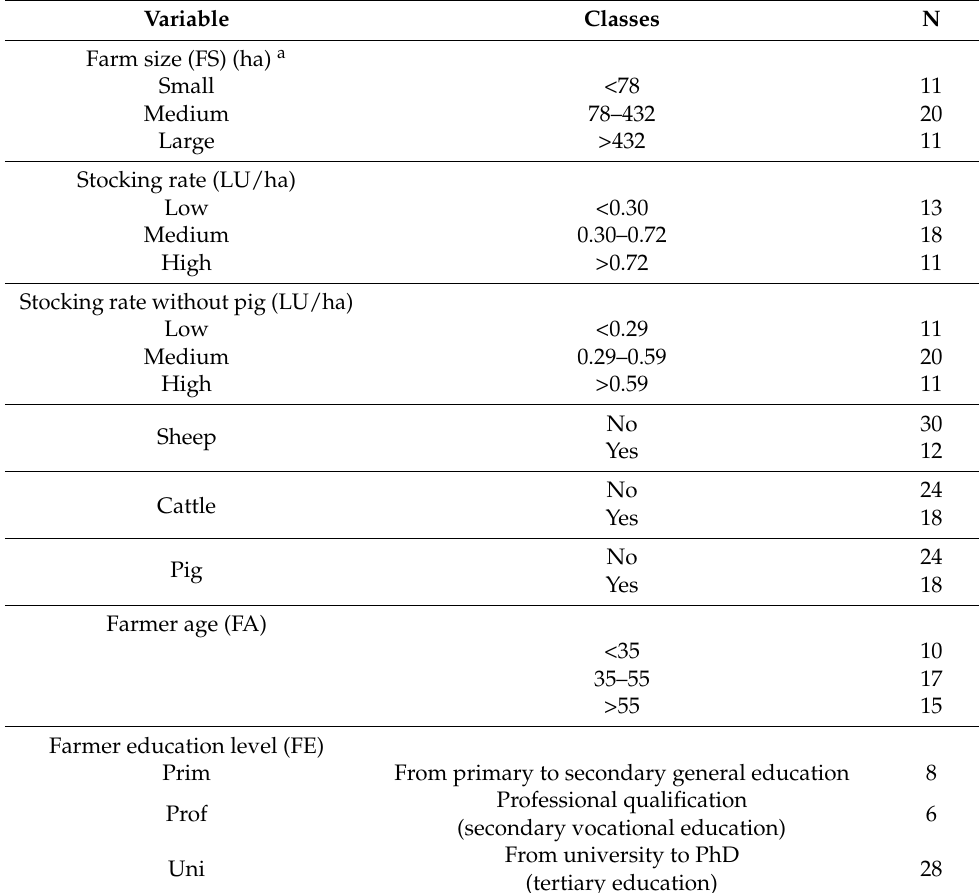
Table 2. Structural variables collected from the